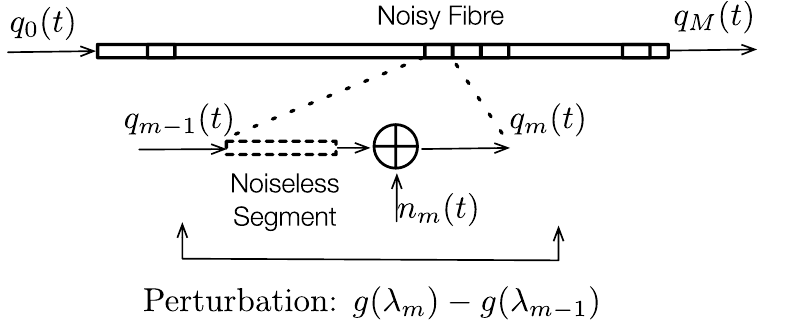
Figure 5. Channel Model: Fiber is considered as a concatenation of M segments. The perturbation of eigenvalues (or their function values) is modelled as the accumulation of many perturbations caused by the addition of noises in each segment. Each perturbation ε m is further modelled as independent, depending only on the deterministically distorted signal q t ( ) m